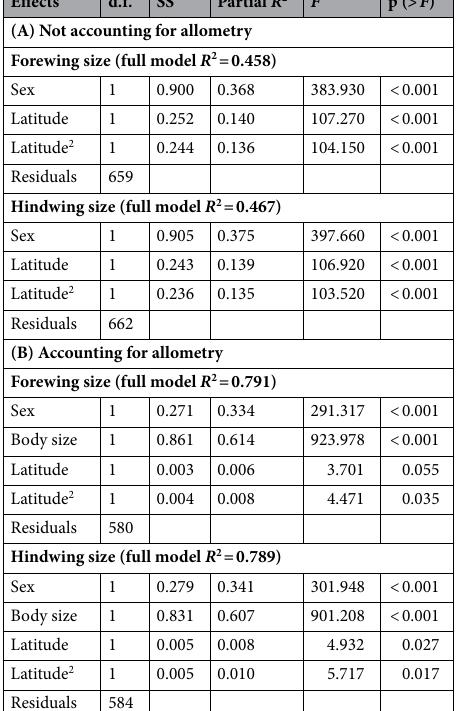
than male wings, and forewings were larger than hindwings in both sexes (mean ± SD, mm: female forewings: 156.77 ± 1.31; female hindwings: 155.18 ± 1.30; male forewings: 155.03 ± 1.28; male hindwings: 153.46 ± 1.28). Wing size also showed a significant U-shaped pattern in relation to latitude (Table 1A, Fig. 2B). Latitude explained 27.6% of the forewing size variation and 27.4% of the hindwing size variation (Table 1A). The shape of the quadratic curve of latitude slightly differed between the sexes (Fig. 2B), although this difference was not significant. The same general linear models were run accounting for the allometric component of wing size by incorporat- ing body size into the models. Wing size showed a strong allometric component for both fore- and hindwings (Table 1B). The slopes of the regressions of wing size on body size were significantly larger than 1 both for fore- (slope ± 95% CI 1.36 ± 0.01) and hindwings (slope ± 95% CI 1.35 ± 0.09). When accounting for allometry, the effect sizes of latitude and its quadratic component accounted for less than 2% of the total wing size variation (Table 1B). Wing ratio. The two general linear models used to study the variation of fore- and hindwing ratio showed that this trait differed between the sexes (Table 2). Wing ratio was larger in males than in females for both wings (mean ± SD: male forewing: 1.22 ± 0.03; male hindwing: 1.21 ± 0.03; female forewing: 1.21 ± 0.03; female hind- wing: 1.21 ± 0.03). Moreover, fore- and hindwing ratio showed a significant positive quadratic relationship with latitude (Table 2). Latitude and its quadratic component accounted for almost 20% of the total variation of wing ratio. Females showed lower values of wing ratio than males at the north edge populations (Fig. 2C), although this difference was not significantly different. Wing shape. Wing shape was studied using geometric morphometrics (13 landmarks and 1 semi-landmark, see Supplementary Fig. S1). To visualize wing shape variation in the entire dataset of fore- and hindwings, a PCA on the wing shape variables was performed, and the variation of wing shape along the first two PCs (variance explained: PC1: 47.71%; PC2: 24.50%) was depicted as thin-plate spline deformation grids (Fig. 3). The plot of PC2 on PC1 showed large overlap between the sexes, but clear separation between fore- and hindwings (Fig. 3). Forewings were longer, slenderer and showed a shorter petiole; hindwings were shorter, broader and had a more elongated petiole (Figs. 3, 4). Two Procrustes ANOVAs on the fore- and hindwing shape variables showed that the effects of sex and latitude accounted for less than 4% of the total wing shape variation (Table 3A). The differences in wing shape between the sexes were indeed subtle: female wings showed an overall slightly broader appearance and a slightly shorter